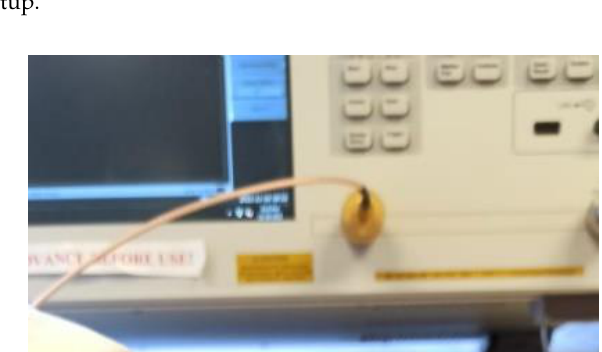
Figure 5. Device validation test setup.